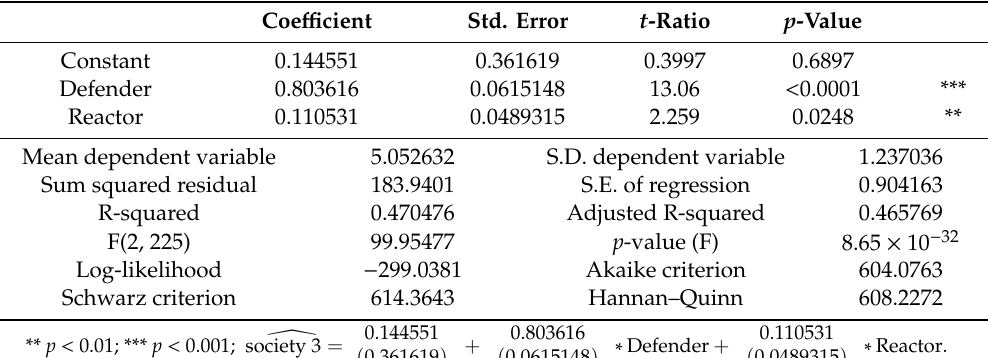
Table 7. Model 7: OLS, using observations 1–228. Dependent variable: Society 3.